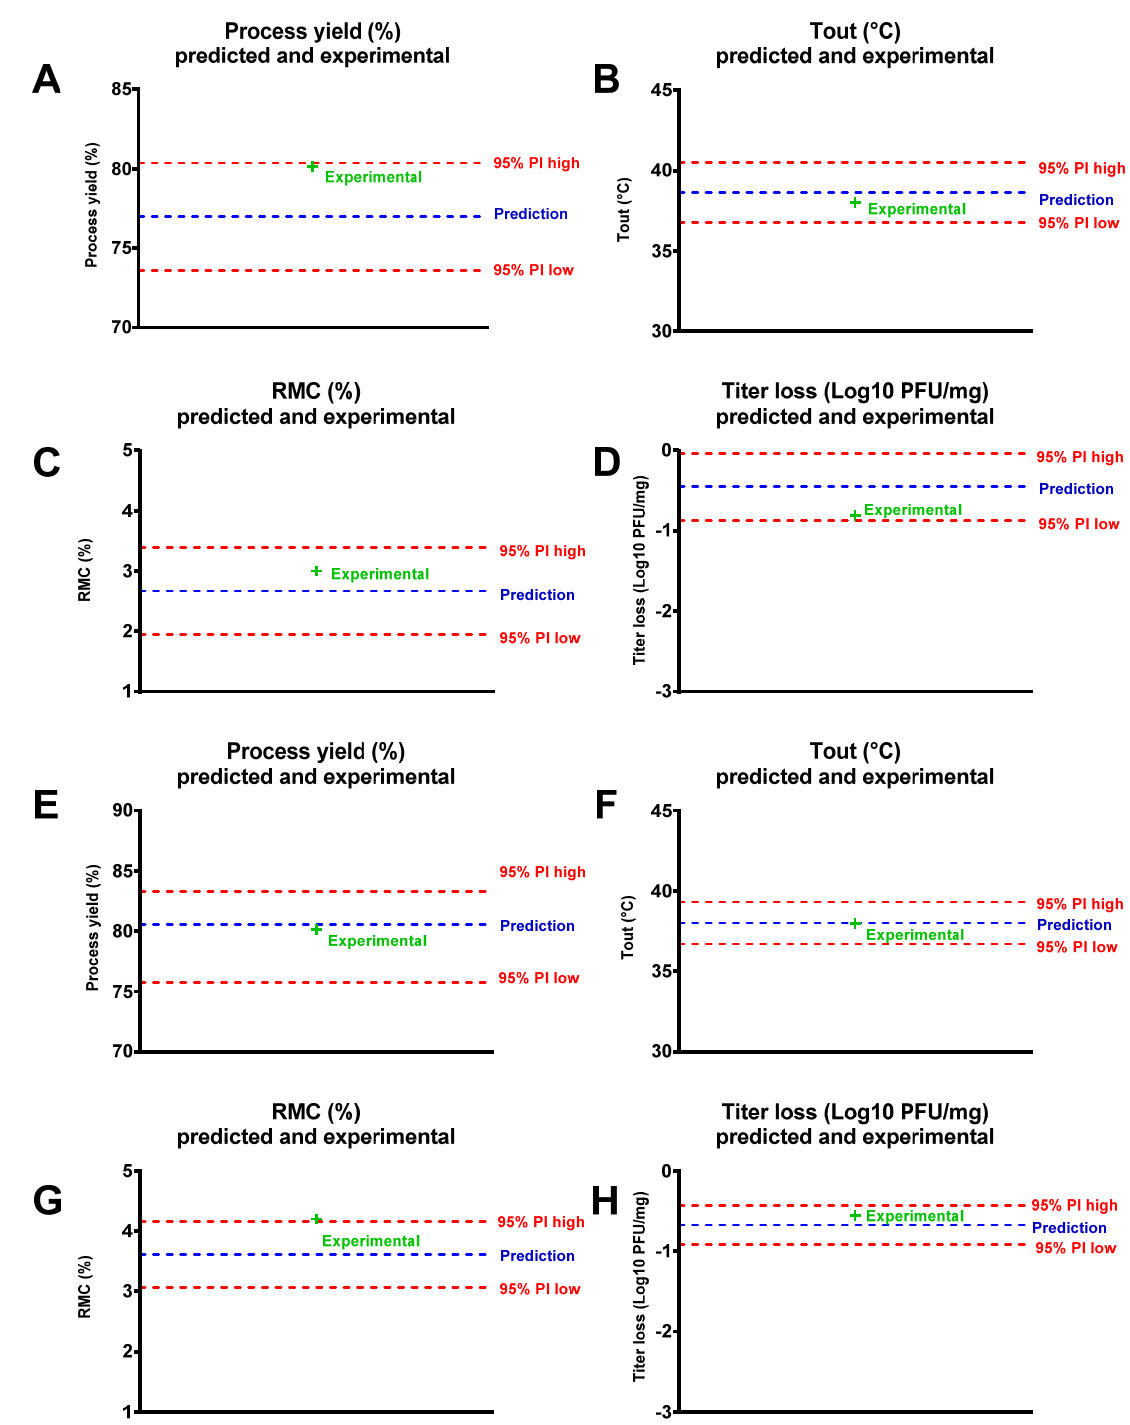
Figure 7. Experimental optimal response compared to prediction, 95% prediction interval (PI) low and 95% PI high for LUZ19 ( A – D ) and 14-1 ( E – H ), for each response.